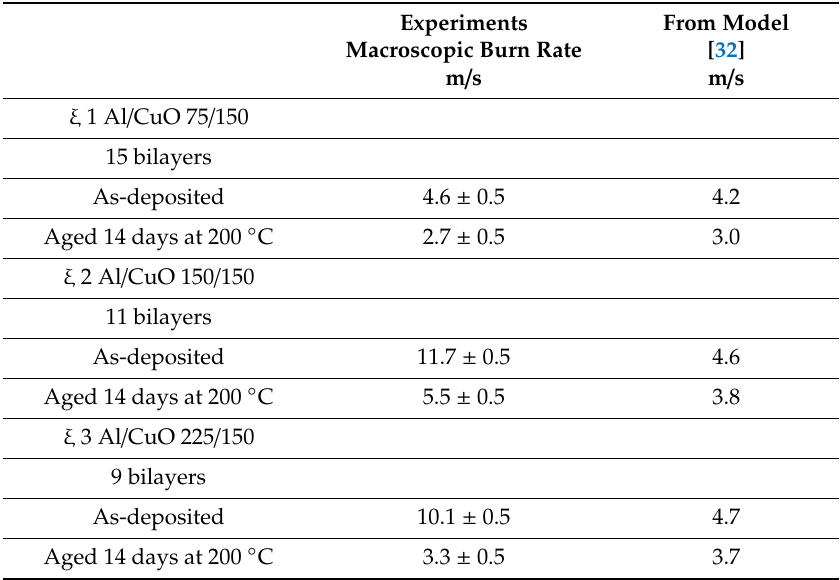
Figure 8. Simulated burn rates of Al / CuO nanolaminates as a function of bilayer thickness for three stoichiometries: ξ 1–3. The total thickness of the nanolaminate as well as heat losses are kept constant by varying the number of bilayers. Solid and dashed curves correspond to as deposited and aged (14 days at 200 ◦ C) nanolaminates, respectively. Table 3. Experimental burn rates obtained on various sputter-deposited Al / CuO nanothermites produced by our team and comparison with theoretical results obtained with a home-built propagation model as detailed in